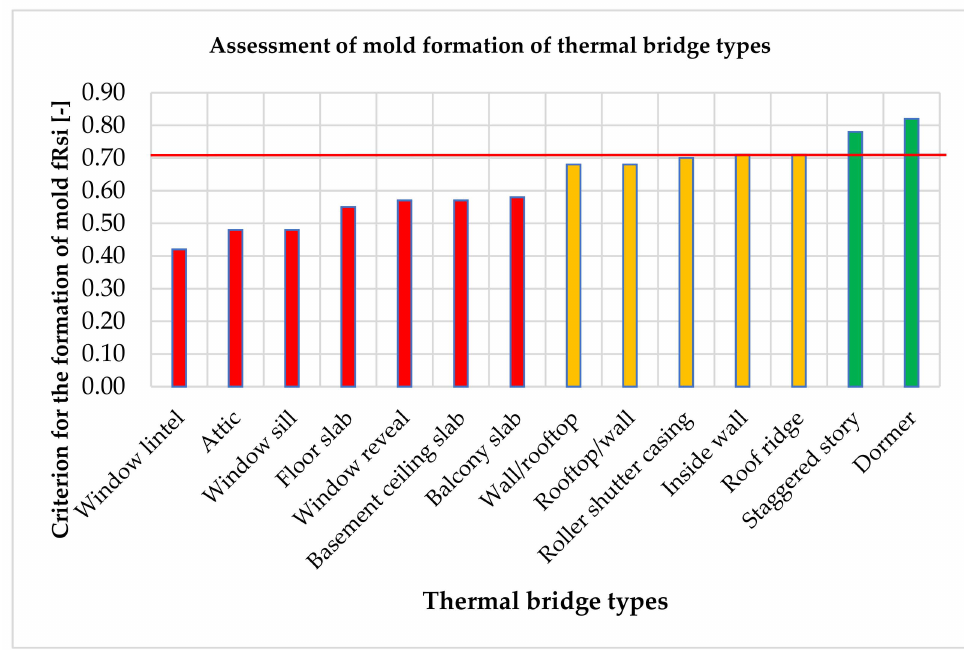
Figure 4. Criterion of mold formation of 14 thermal bridges in German buildings constructed between 1950 and 1969 prior to a retrofit (based on simulations with ThermCad). The red line marks the mold formation criterion of 0.7. Thermal bridge types with a red bar are clearly lower, with a yellow bar close to, and with a green bar clearly higher than